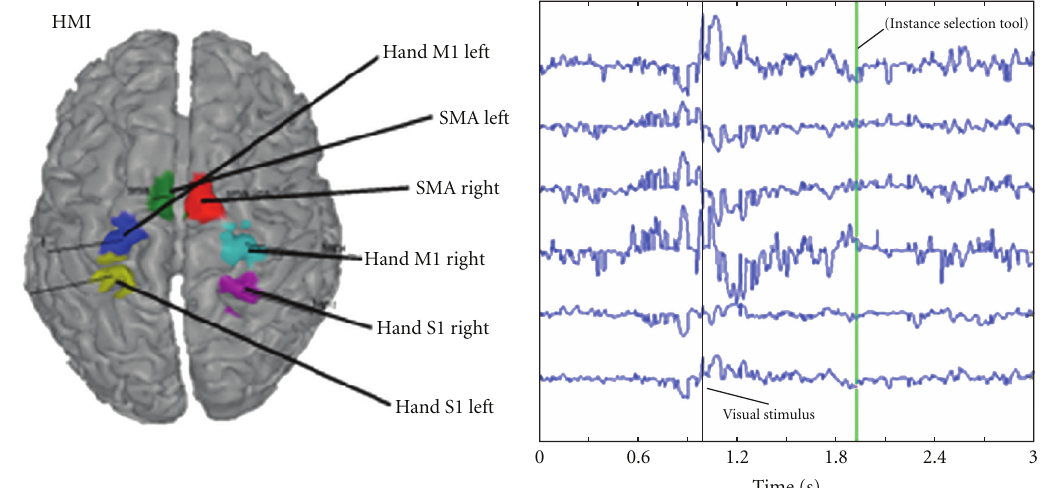
Figure 8: Regions of interest activation time series of a small functional cortical network (FCN) of one representative subject during Hand Motor Imagery (HMI).